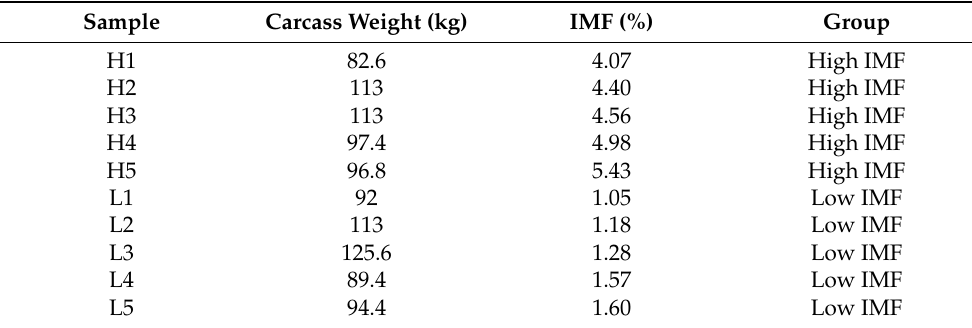
Table 1. Description of IMF content between the two groups.